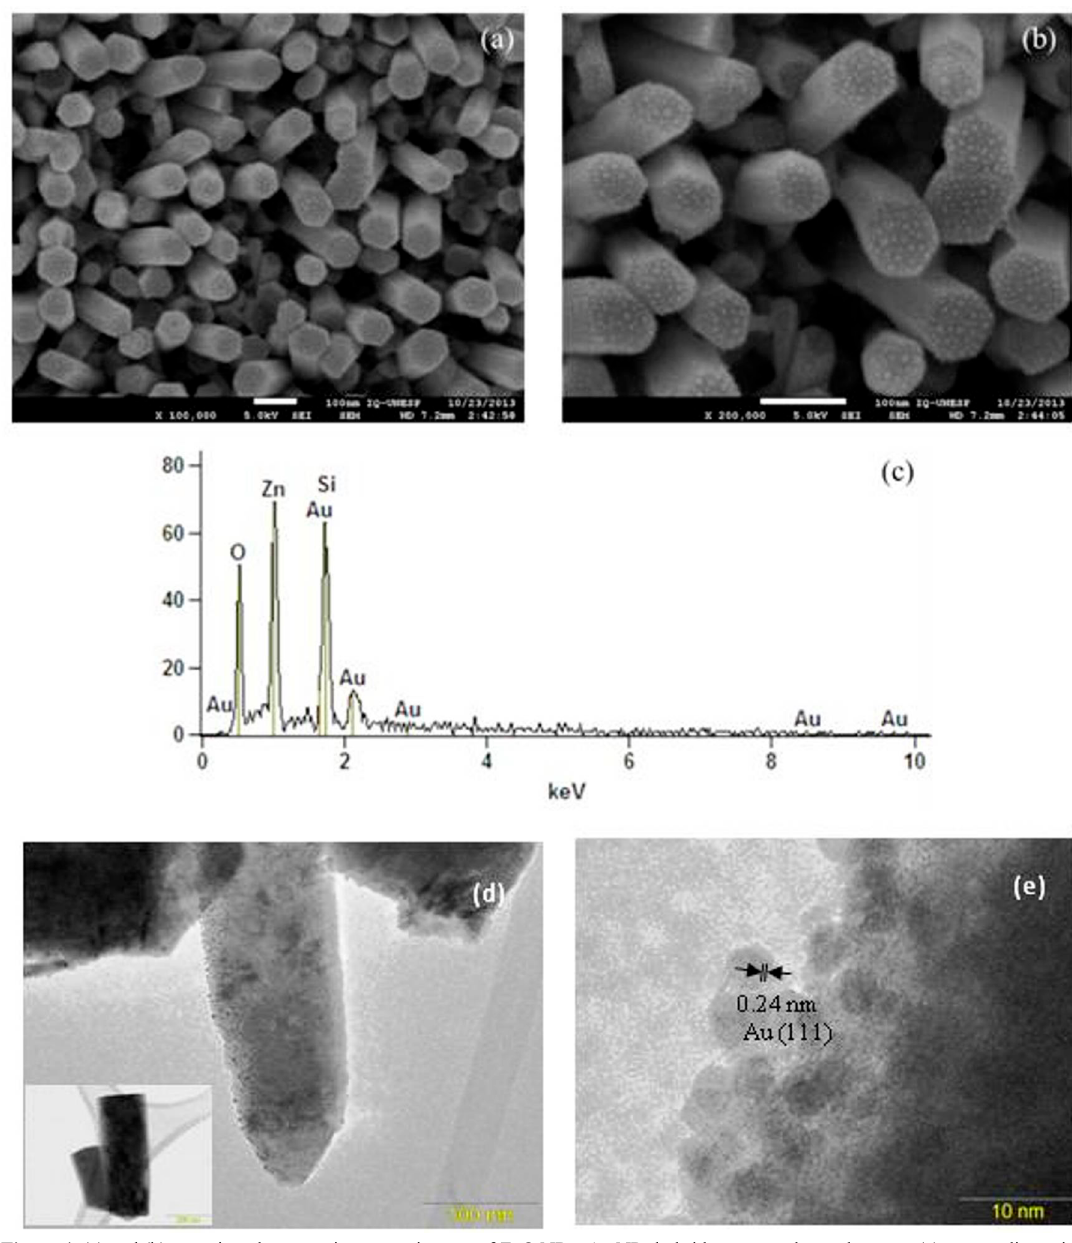
Figure 4. (a) and (b) scanning electron microscopy images of ZnO NRs- Au NPs hybrids supported on substrates, (c) energy dispersive X-ray spectroscopy spectrum of the ZnO NRs- Au NPs hybrids, (d) HRTEM image of ZnO NRs-Au NPs hybrids and (e) HRTEM Electron Diffraction of Au